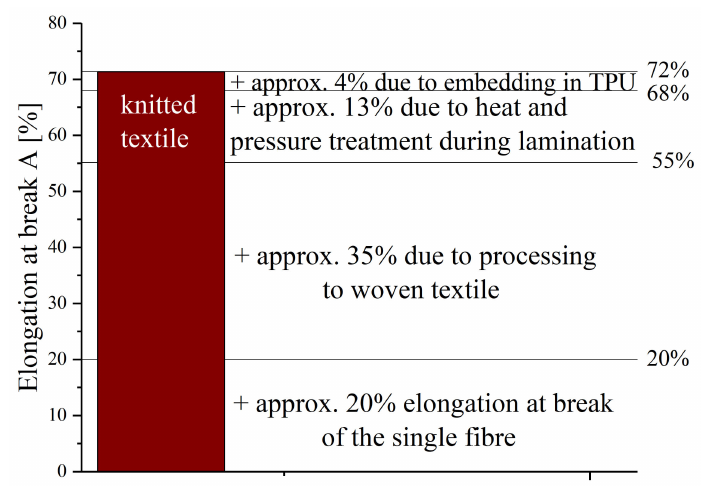
Figure 8. Influence of the process steps on the elongation at break point of the knitted fabric samples (absolute indication of the elongation at break